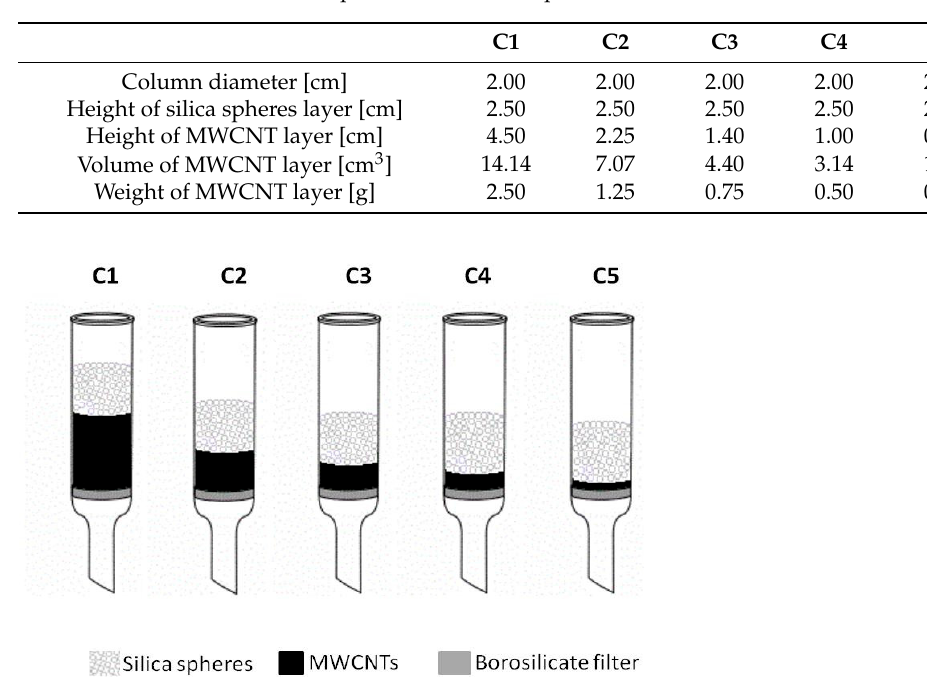
Table 1 . Characteristics and composition of the adsorption columns . Table 1. Characteristics and composition of the adsorption columns.